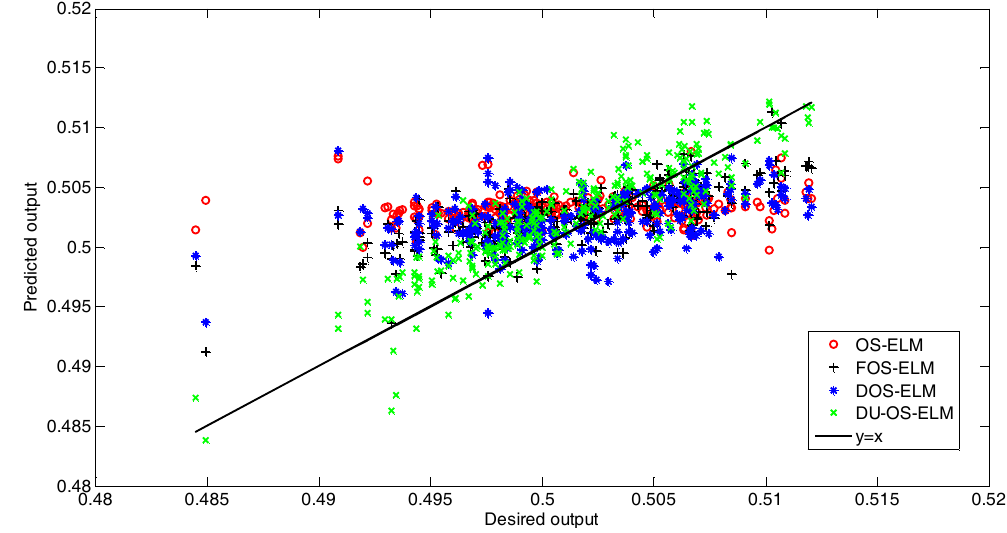
Figure 11. The correlation between the predicted values and desired values.